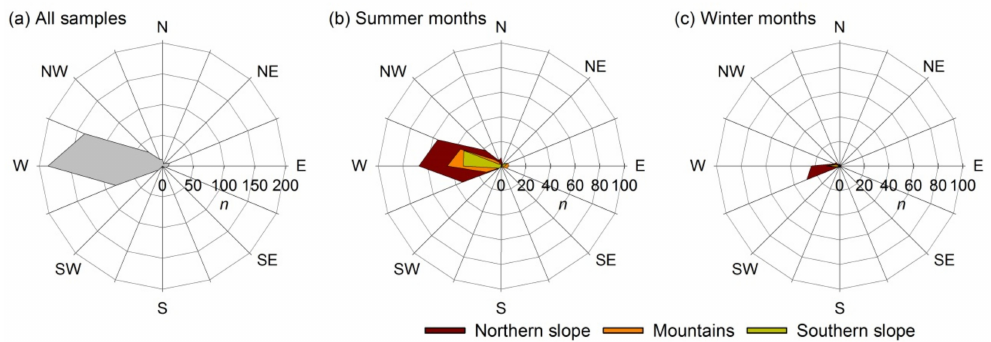
Figure 4. Directions of moisture source further than 300 km around the Tianshan Mountains all year round ( a ), during summer months ( b ) and winter months ( c